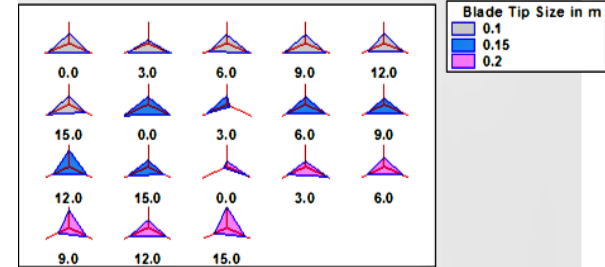
Figure 6. Sunray plot for turbulence intensity with different blade tip sizes of 0.1, 0.15, and 0.2m and blade twist angles of 0, 3, 6, 9, 12, and 15 ◦ for three airfoils.